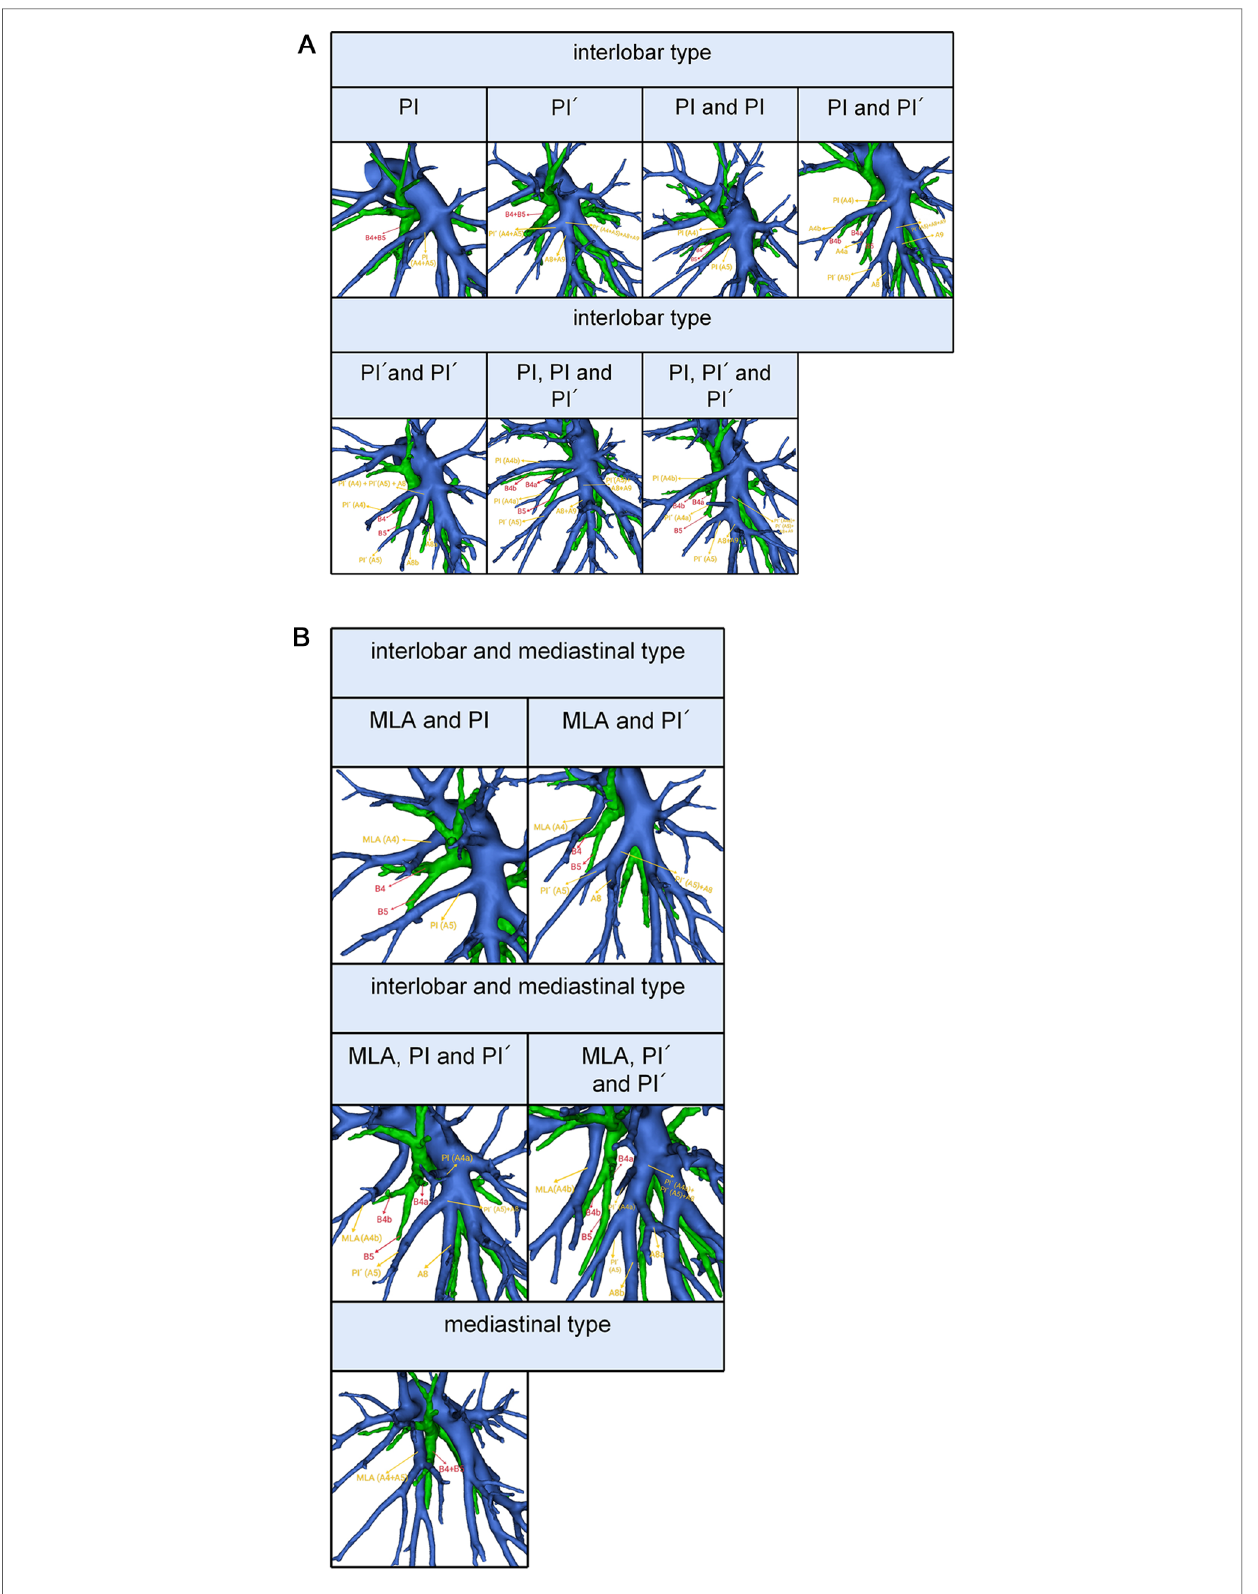
FIGURE 3 ( A ) 3D reconstruction model of branching patterns of the lingular segment artery in the interlobar type. ( B ) 3D reconstruction model of branching patterns of the lingular segment artery in the mediastinal type and the interlobar and mediastinal